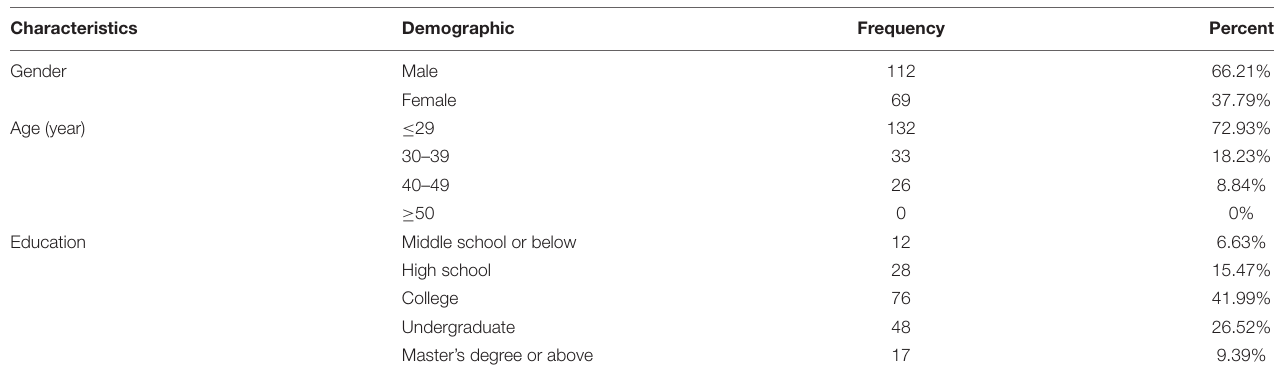
TABLE 1 | Sample demographics ( N =